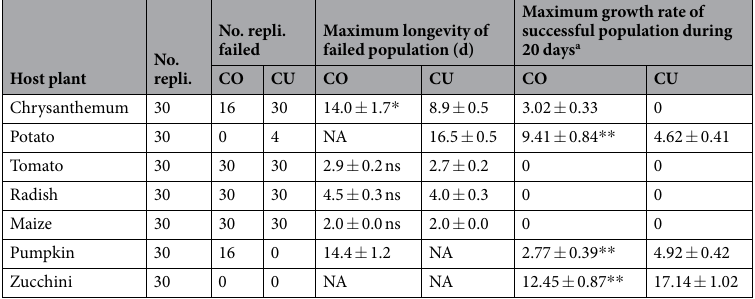
Table 1. Performance of cotton- and cucurbit-specialized aphids on different host plants. a Successful population is defined here as that in which size was more than 2-fold of its original number after 20 days on a host plant.